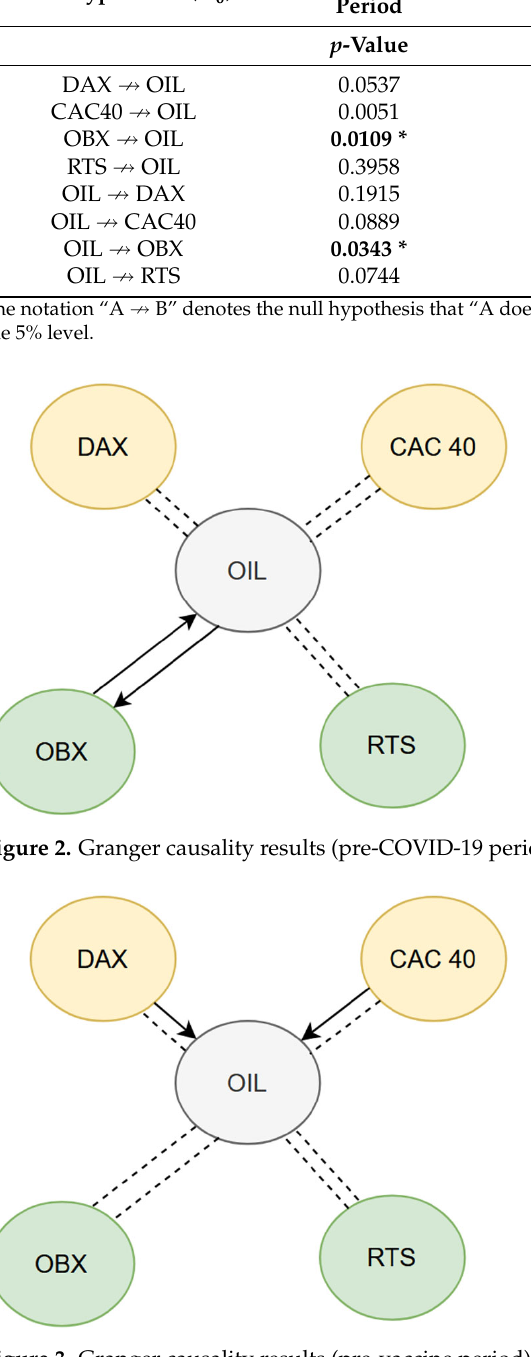
Figure 4. Granger causality results (post ‐ vaccine period). In addition, Johansen’s methodology is applied for our selected time ‐ series to exam ‐ ine the possible existence of cointegrating equations between them. Tables 4–9 test the null hypothesis for no existence of a cointegrating equation between the selected time ‐ series. The results for the trace and maximum eigenvalue tests for the selected sub ‐ periods show that the null hypothesis for the non ‐ existence of a cointegrating equation between the selected time ‐ series cannot be rejected at a 5% significance level. More specifically, as we present in Tables 4 and 5, for the pre ‐ COVID ‐ 19 period, the p ‐ values of trace test and max ‐ eigen test are both greater than 0.05 and therefore the null hypothesis cannot be rejected in the first step. Therefore, the results imply that there exists no long ‐ run relationship between the variables. Moreover, as is presented in Tables 6 and 7, for the second sub ‐ period, the pre - vac ‐ cine period, the p ‐ values of the relevant tests are both greater than the critical value in the first step. Thus, the H 0 cannot be rejected, which means that there are no cointegrating equations. Table 4. Trace statistic—Johansen cointegration method (pre ‐ COVID ‐ 19 period). Hypothesized no. of CE(s)